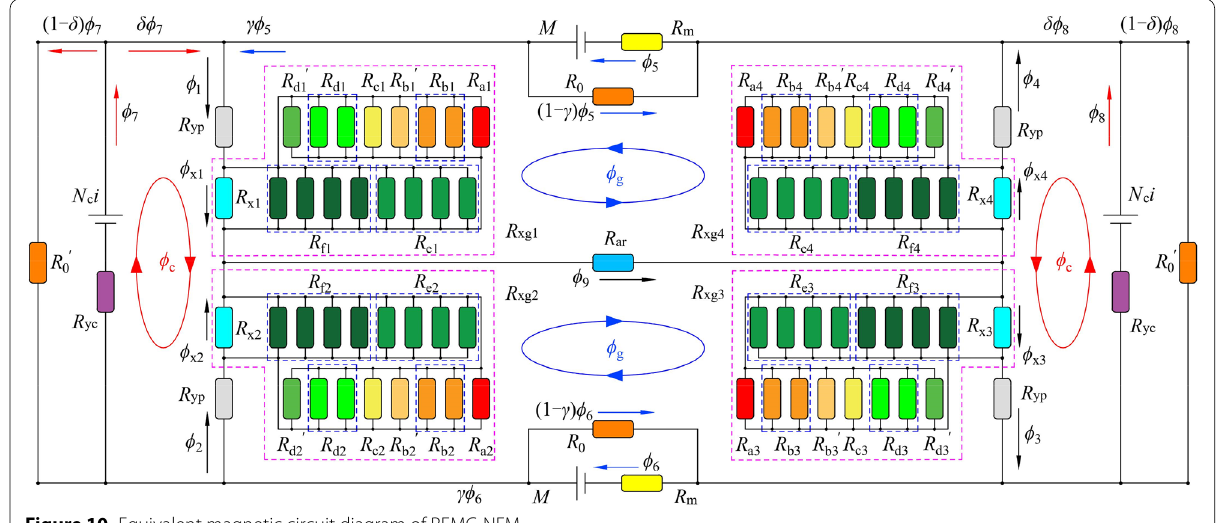
Figure 10 Equivalent magnetic circuit diagram of REMC-NFM